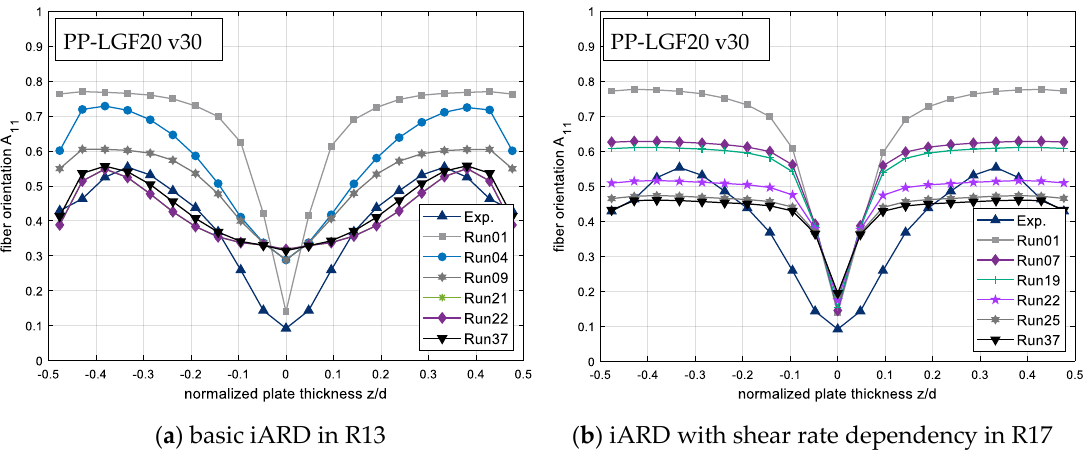
Figure 20. Results of the direct parameter optimization by coupling MATLAB ® and Moldex3D ®.